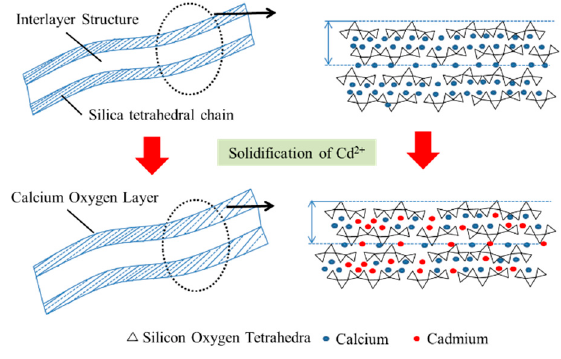
2 + on the C–S–H gel structure. Figure 8. Impact of Cd 2+ on the C–S–H gel structure. Figure 8. Impact of Cd